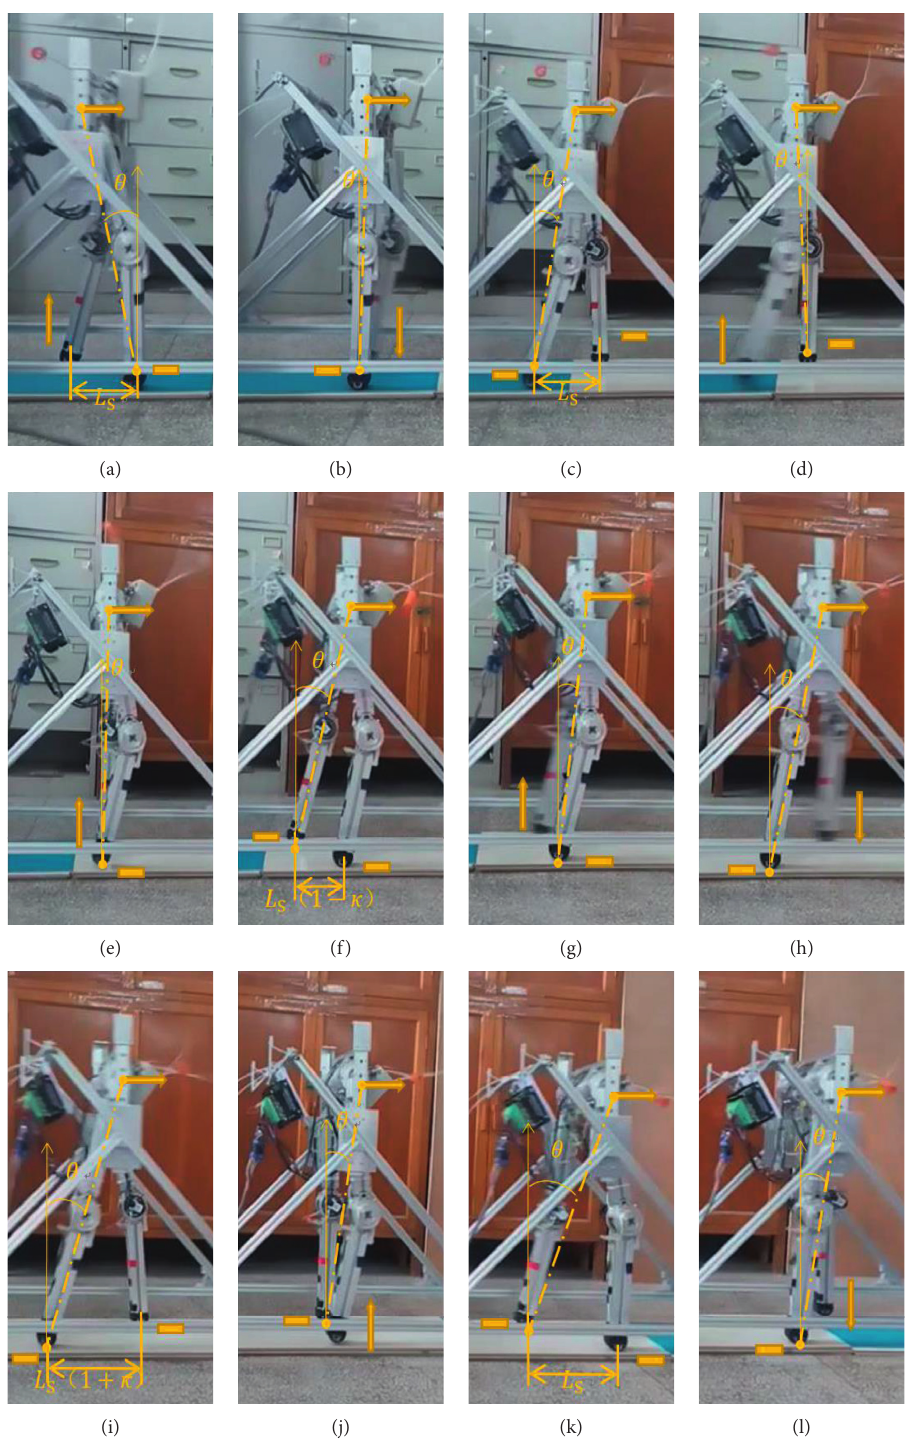
Figure 7: Proceeding of UABOT striding over a pothole where κ � 0 . 32 and the compliance of ground is nonidentical (“ ↓↑ ”: direction of foot movement, “ − ”: sole being in contact with the ground surface, “ ⟶⟵ ”: direction of hip movement, “NG”: nominal gait, SG: gait with short step-length, LG: gait with long step-length, and RG: gait for back leg recovery). (a) Initial stage of NG. (b) SSP of NG. (c) Final state of NG. (d) Initial state of SG. (e) SSP of SG. (f) Final state of SG. (g) Initial state of LG. (h) SSP of LG. (i) Final state of LG. (j) SSP of RG. (k) Final state of RG. (l) SSP of